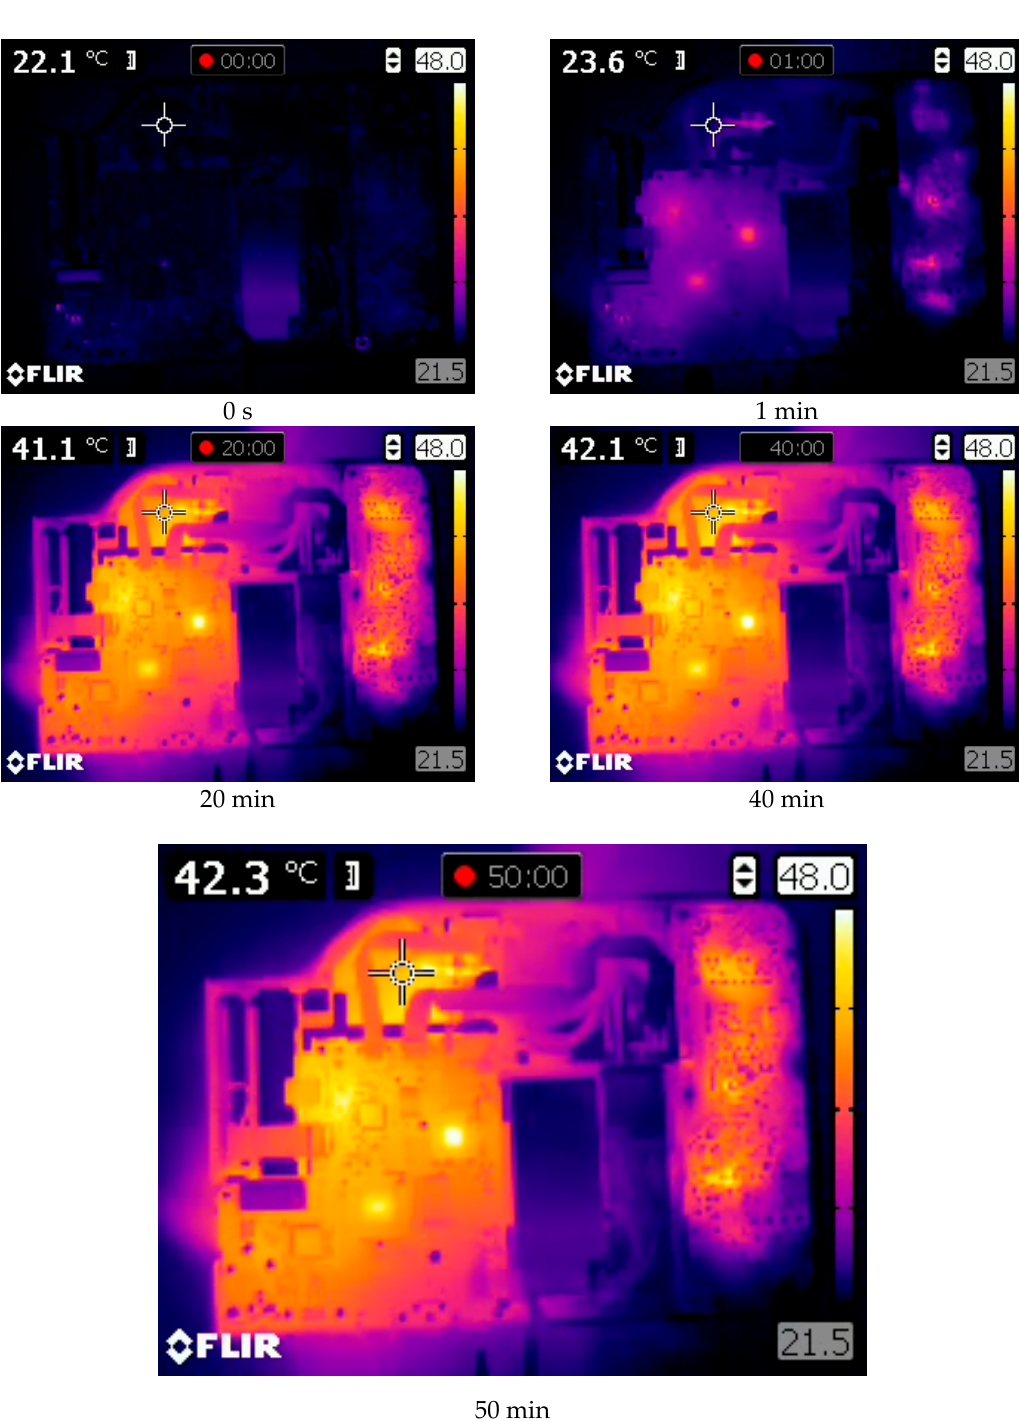
Figure 5. The warming-up process of the DLP Casio XJ-A252 projector, registered with the thermal camera Flir E40. The top plate of the projector was removed to show the inside of the projector. The measuring point is located on the housing of the optical system.